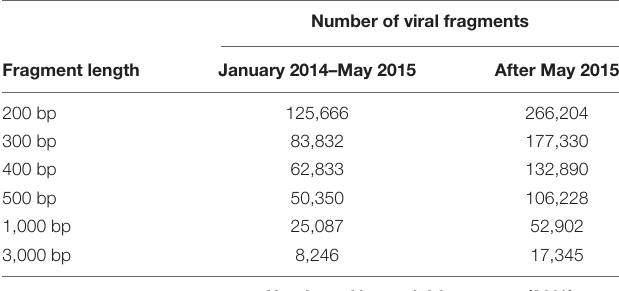
TABLE 1 | The number of fragments generated from viral and bacterial genomes discovered after 1 January 2014. Number of viral